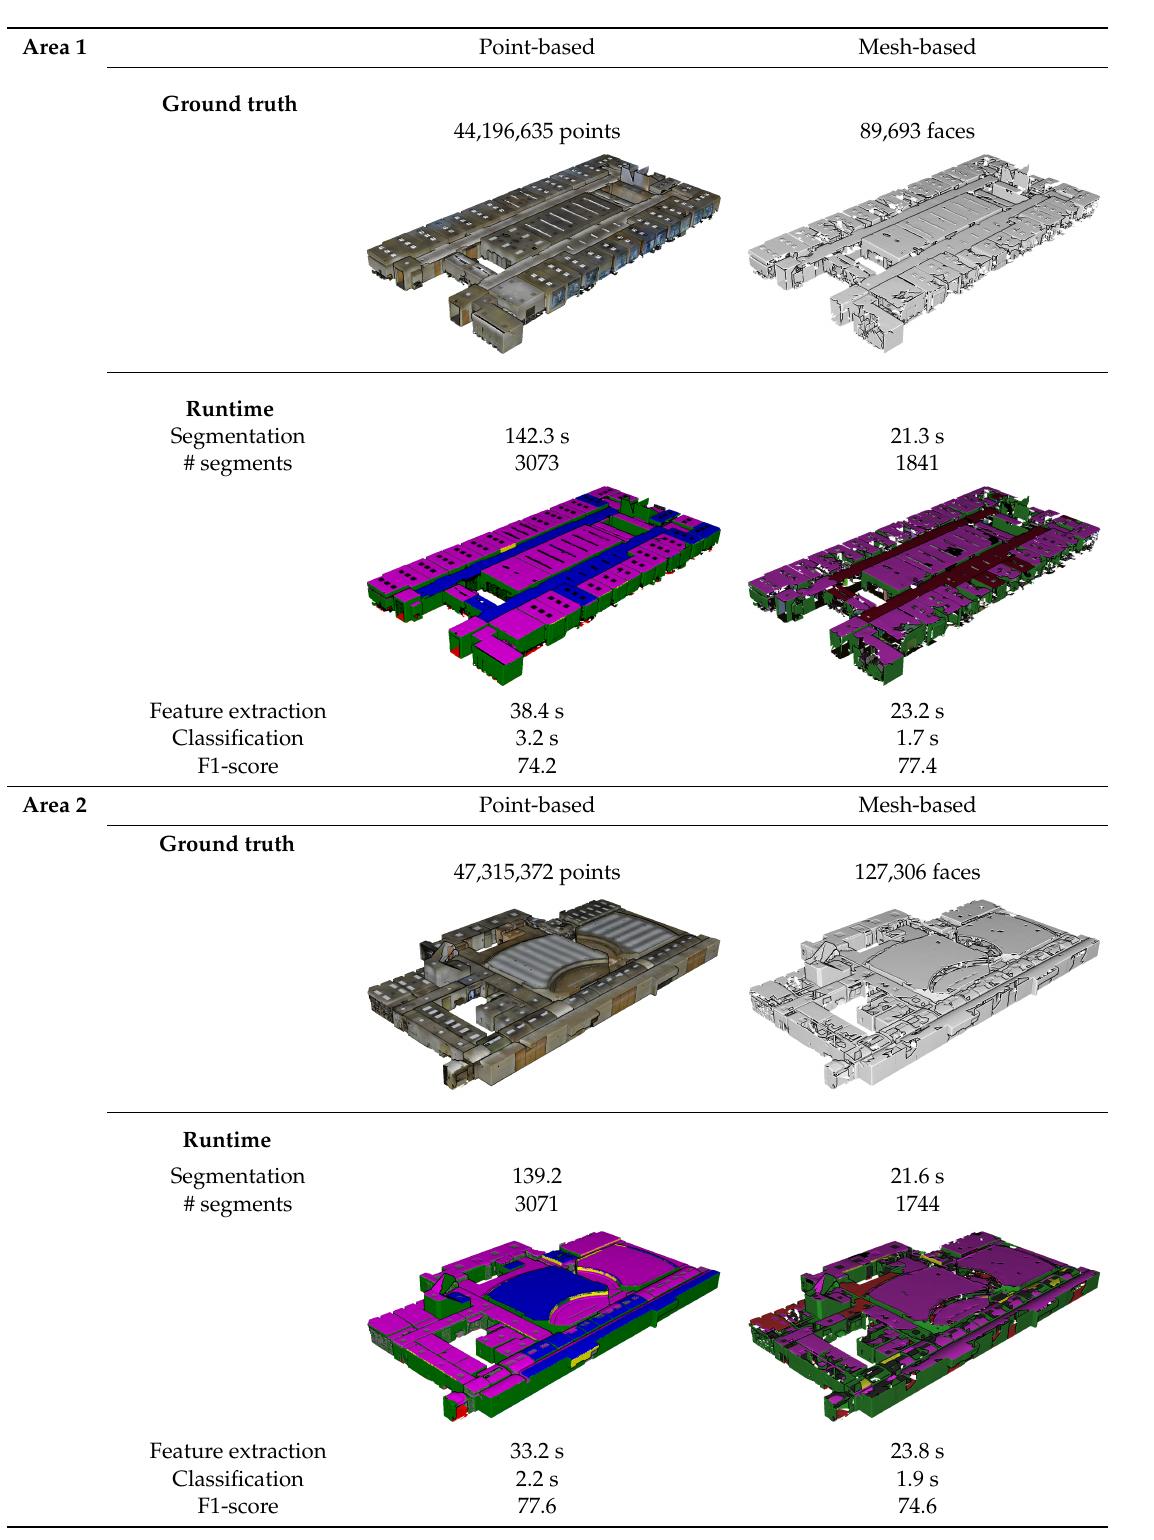
Figure 4. Process information of the point-based and mesh-based